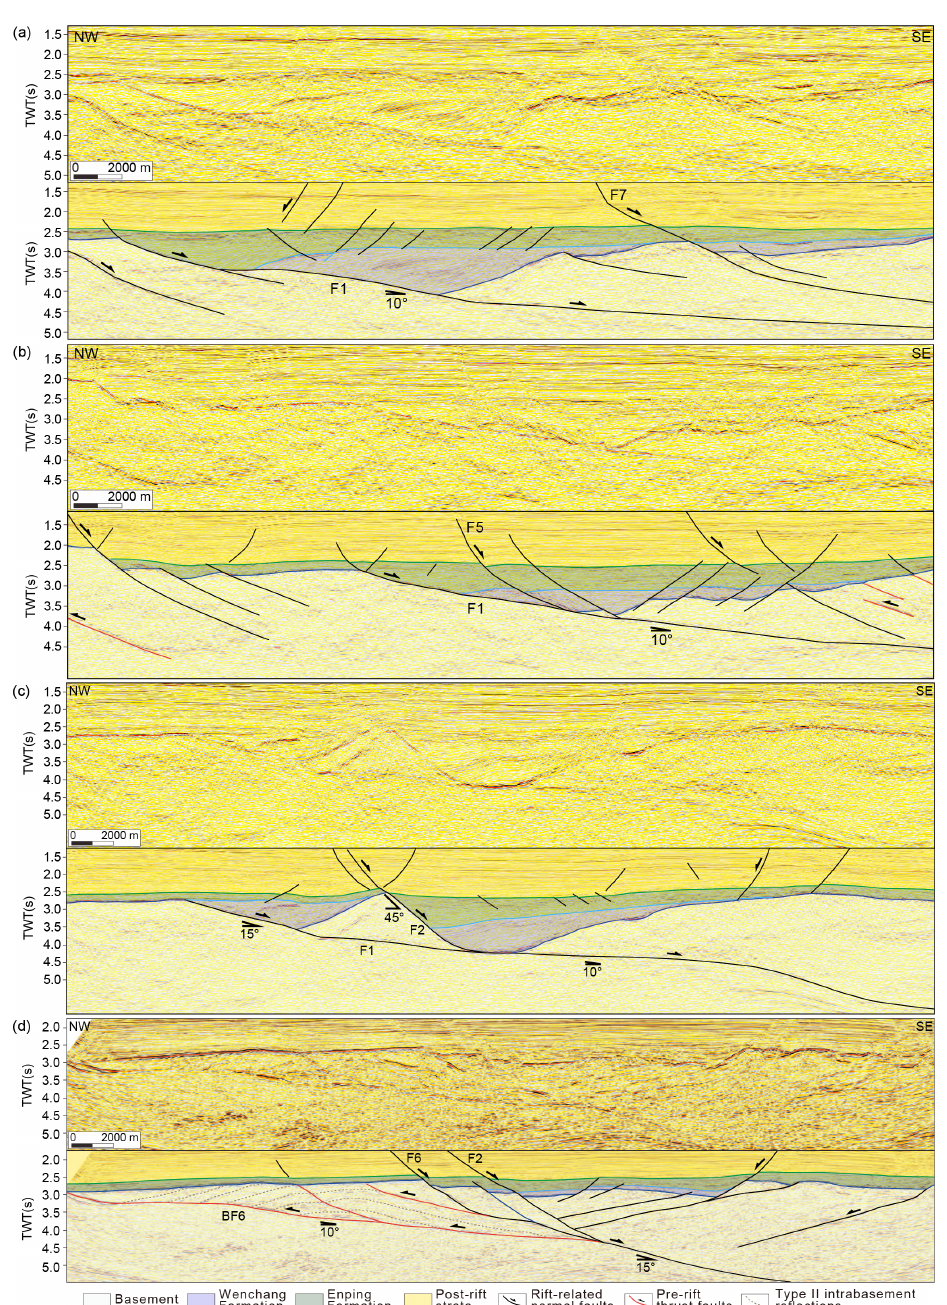
Figure 6. Cross sections perpendicular to the major structural trend showing the geometry of the major fault F1 and hanging-wall half-graben. Panels (a) – (d) are four uninterpreted and interpreted cross sections sub-perpendicular to the local strike across fault F1 using the simplified interpretation of stratigraphy. The colours used for the key horizons and stratigraphic intervals between them are consistent with those used in Fig. 2. See Fig. 1 for the location of these cross